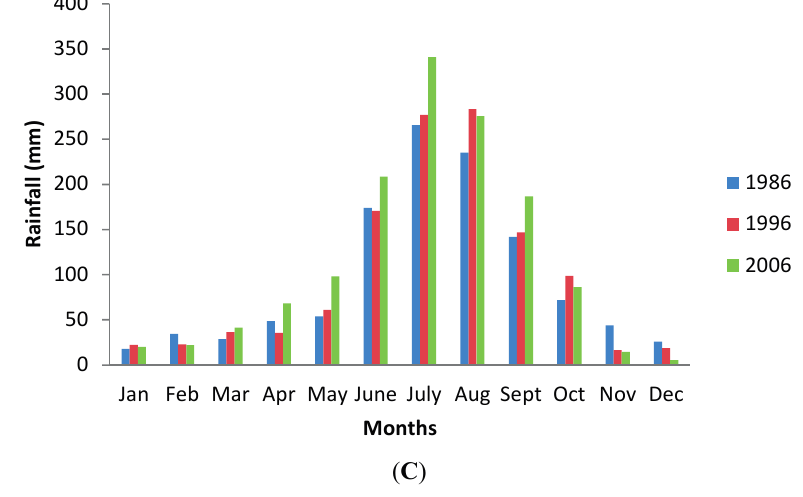
Figure 12. The monthly average rainfall pattern was lowest during 1984–1986 ( A ); compared to 1994–1996 ( B ); and 2004–2006 ( C ). The rainfall pattern has affected net cropland area during the mapping